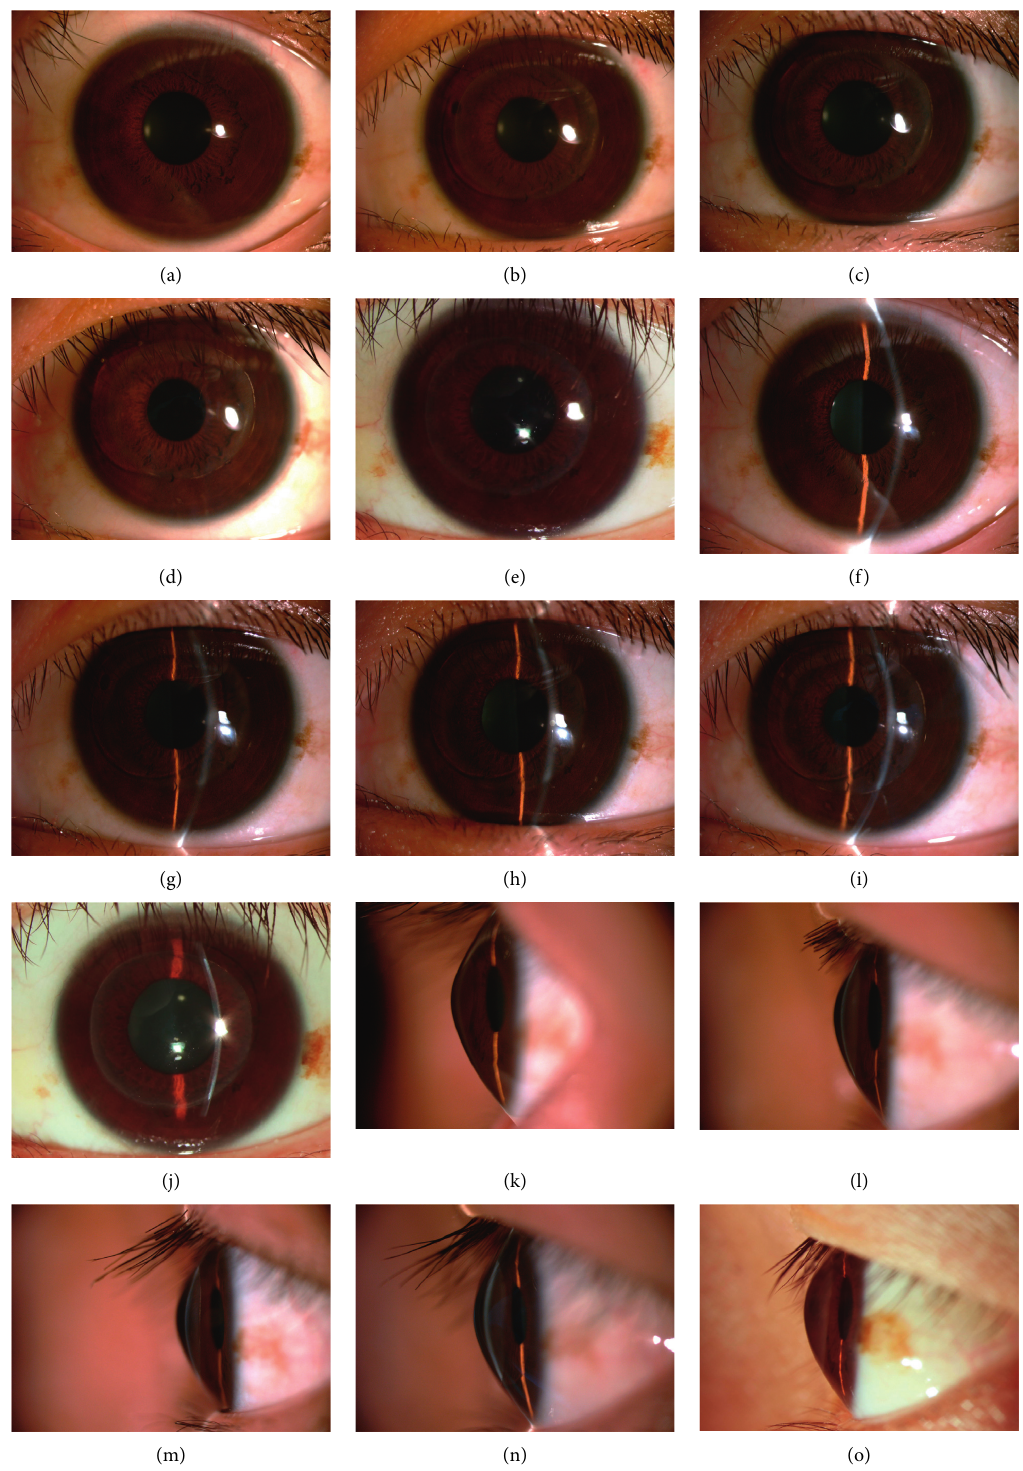
Figure 2: (a, f, k) The slit-lamp microscope images of preoperative patients with cone shaped. (b, g, l) All operated eyes did not show corneal ulceration, corneal neovascularisation, and exudate in the anterior chamber at 1 week postsurgically. (c, h, n) At 1 month postsurgically, slit lamp microscope showed that corneal stromal edema was considerably reduced compared to 1 week postsurgically. (d, i, m) Corneal stromal edema greatly subsided after 3 month postsurgically. (e, j, o) At 60 months postsurgically, a scar line was observed at the periphery of the lenticule, while the central region remained